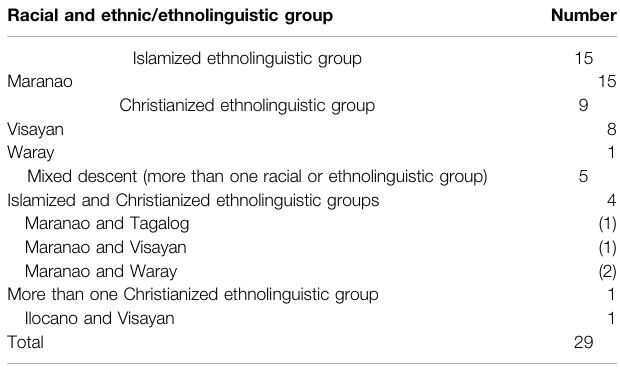
TABLE 1 | Racial and ethnic background of interview participants.